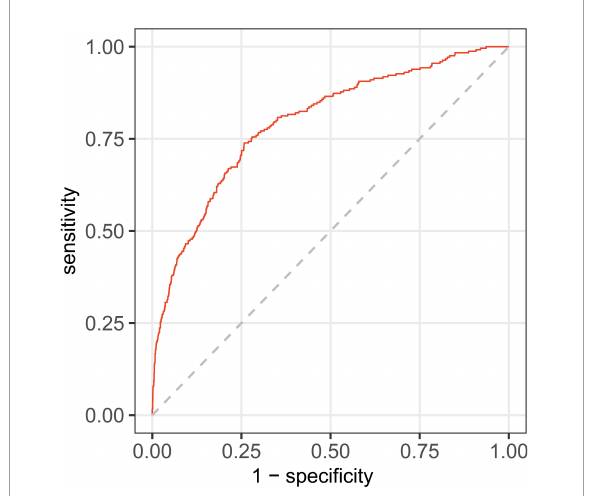
FIGURE5 Receiver operating characteristic curve for nomogram in predicting the incidence of new-onset atrial fibrillation (NOAF) in patients with acute myocardial infarction